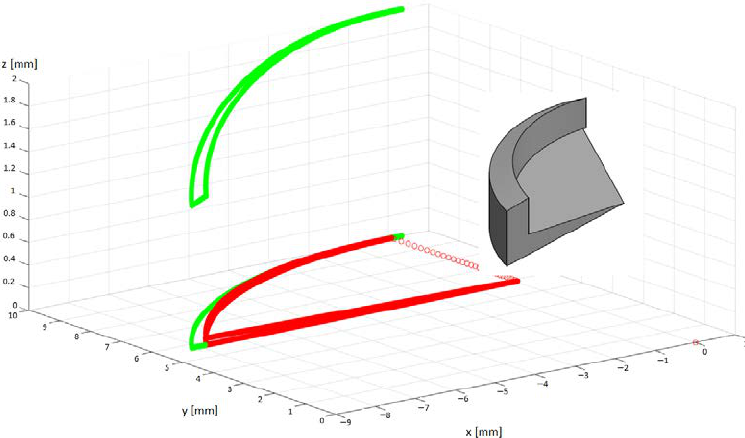
Figure 8. 3D representation of the uncut chip geometry, green-flank uncut chip area and red end uncut chip area.